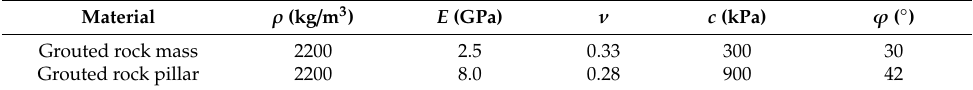
Table 4. Material properties of grouted rock mass and rock